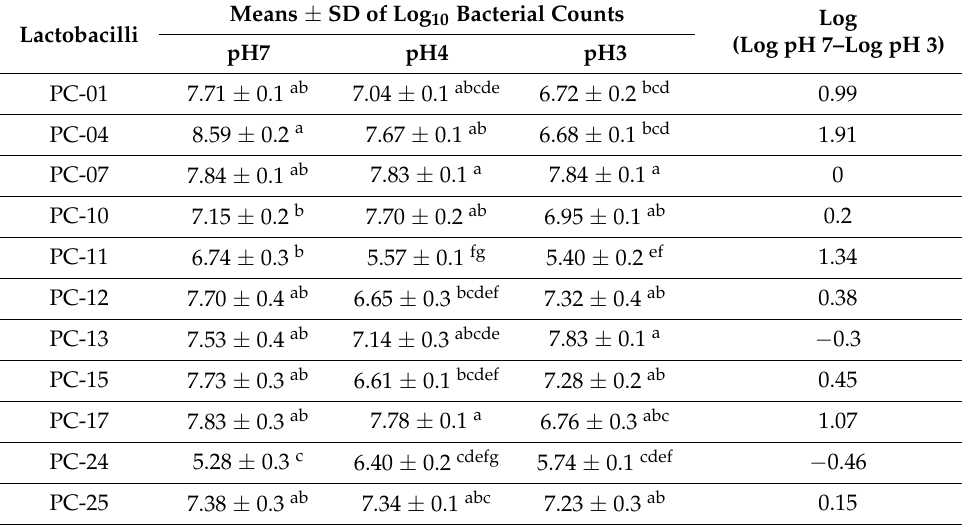
Table 1. Lactobacilli count on MRS agar after treatment in MRS broth of different pH.